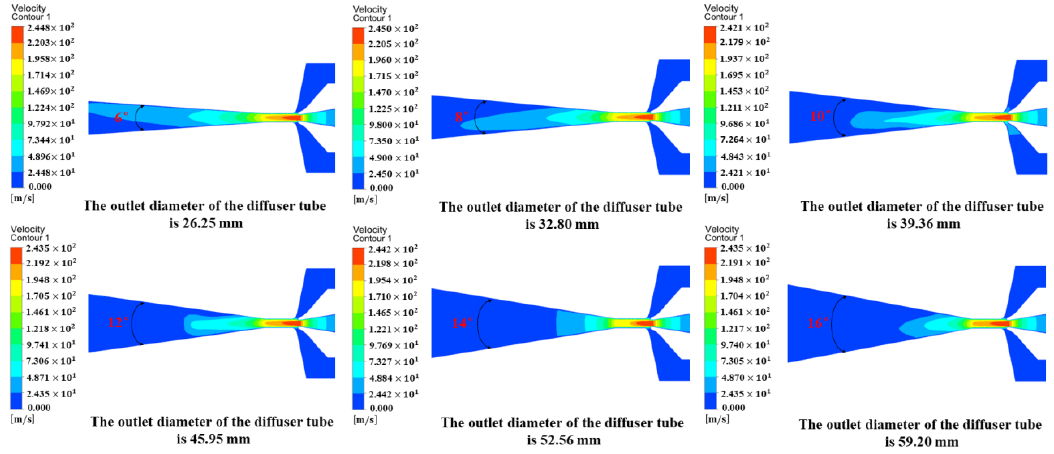
Figure 9. Velocity cloud diagrams of the diffuser tube with different diffuser angles.